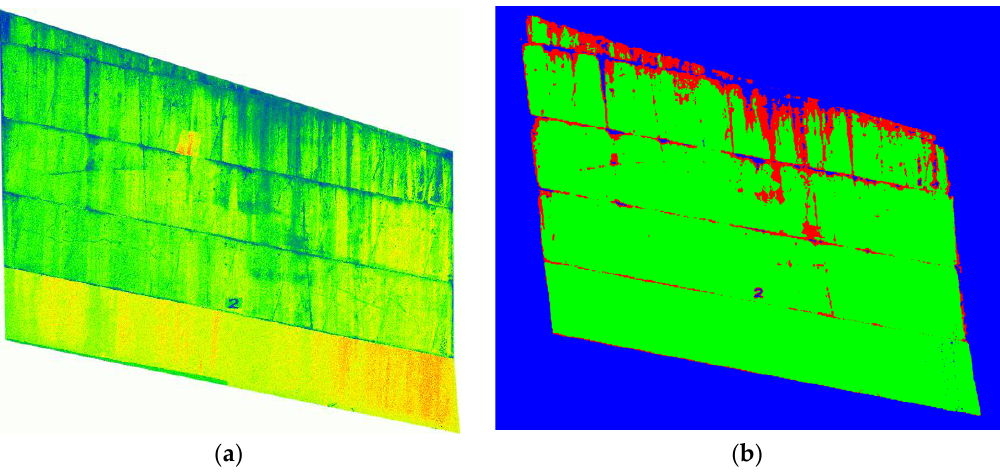
Figure 3. Image segmentation by K-means clustering (K = 3). ( a ) Original image; ( b ) Image segmented by K-means clustering (K =